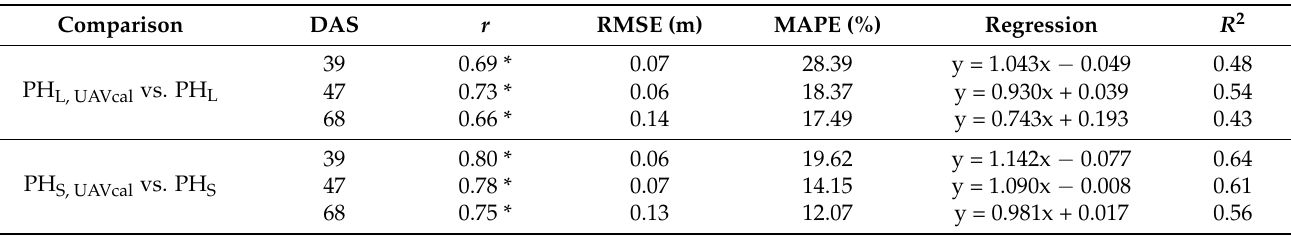
Table 3. Predictive analytics of calibrated plant height estimated by UAV (PH L, UAVcal, PH S, UAVcal ) vs. measurement of highest leaf (PH L ) and highest straightened leaf (PH S ); DAS: Days after sowing, r : Pearson’s correlation coefficient, RMSE: Root mean square error, MAPE: Mean absolute percentage error, R 2 : Coefficient of